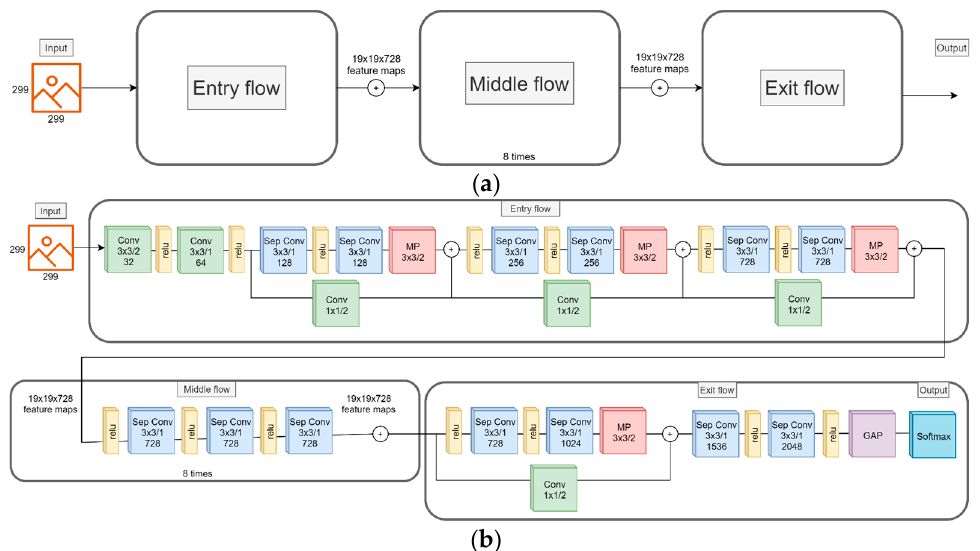
Figure 4. Xception model. ( a ) Shows the general structure of Xception model; ( b ) shows the detailed architecture of the original Xception model. After each convolution and separable convolution block, a batch normalization operation is performed. In a Conv block, for example, the first number indicates the size of the kernel, the second number indicates the size of the stride, and finally, the last number indicates the number of filters used in each specific block.